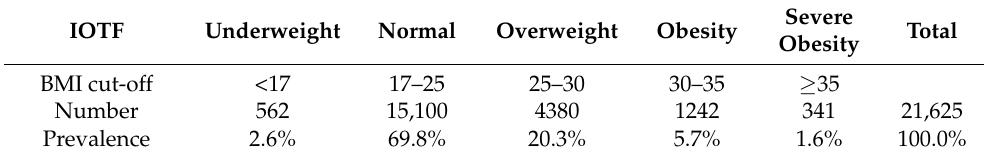
Table 8. Prevalence of underweight, overweight, obesity and severe obesity using IOTF